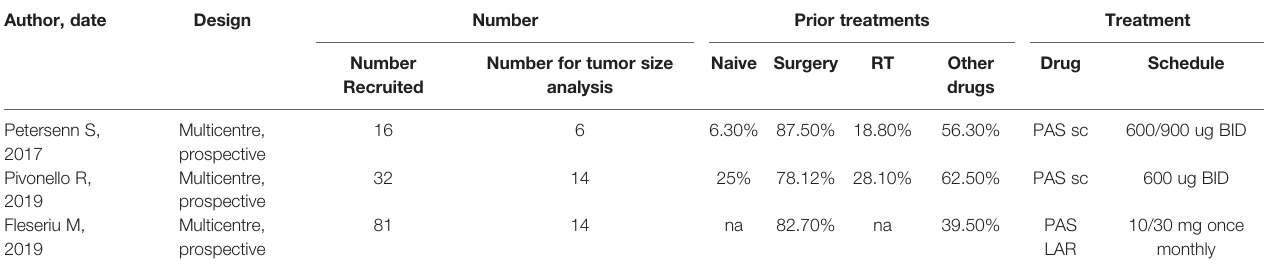
TABLE 3 | Studies considered for the metanalysis in Cushing ’ s Disease.